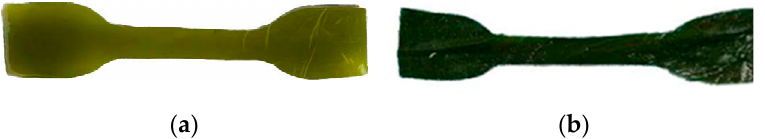
Figure 7. The sample of wakame stem and leaf ( a ) Stem; ( b ) Leaf.